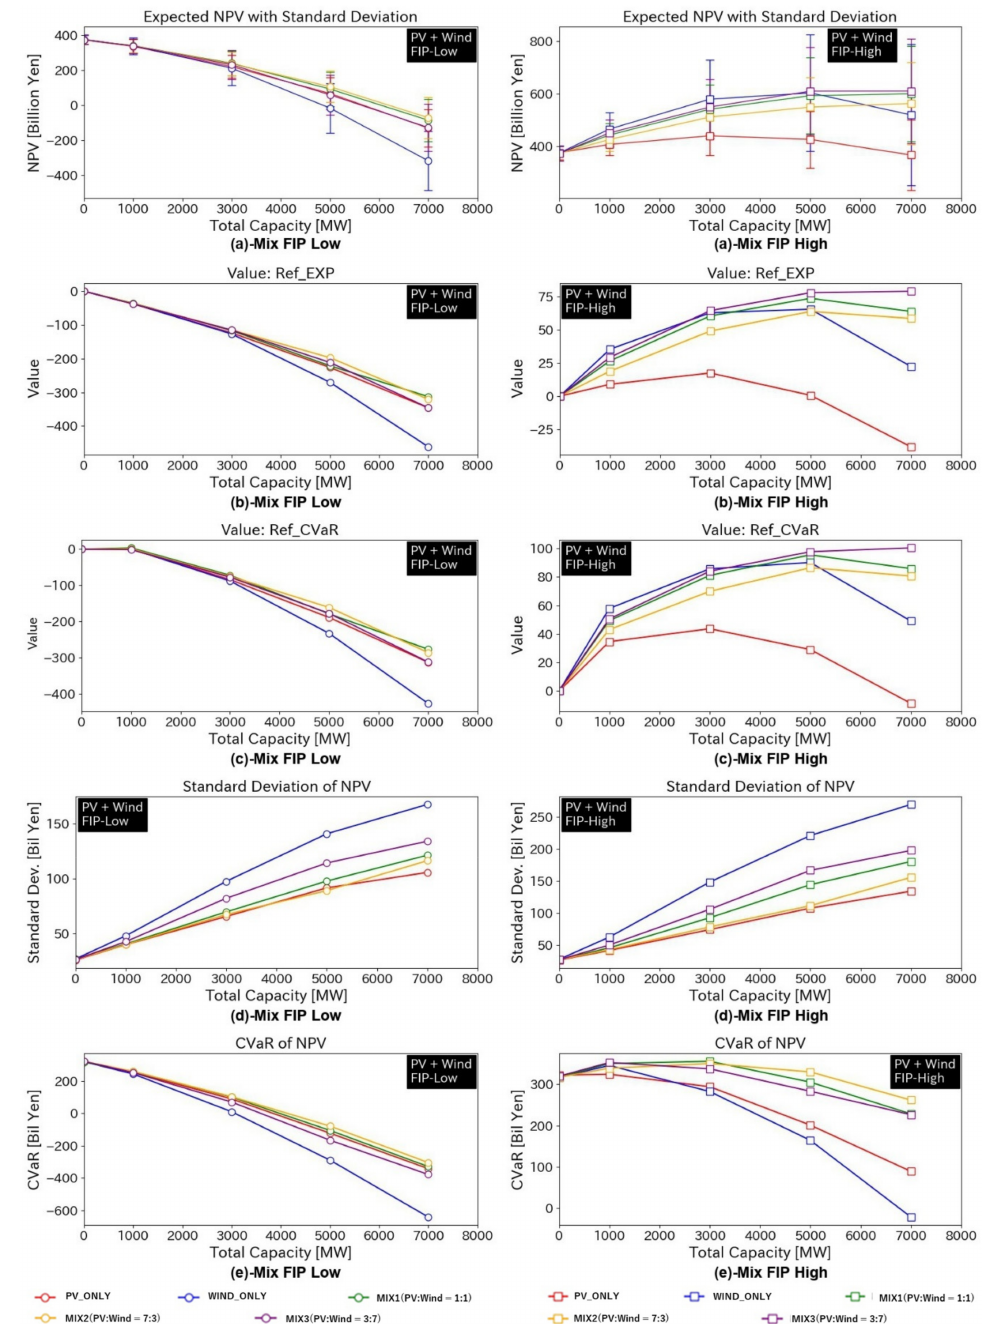
Figure 10. Results of the mixture of VRE: ( a ) Expected NPV with standard deviation, ( b ) Value in case of high RFP, ( c ) Value in case of low RFP, ( d ) Standard deviation of NPV, and ( e ) CVaR of NPV. By comparison, in the case of high FIP, when Company 2 adopted strategies to make a balanced investment in PV and wind, investment in VRE could be expedited compared to the strategies of PV or wind only (Figure 10a (a)-Mix FIP High, Figure 10b (b)-Mix FIP High, Figure 10c (c)-Mix FIP High). The expected NPV and Value of MIX1 (PV:Wind = 1:1), MIX2 (PV:Wind = 7:3), and MIX3 (PV:Wind = 3:7) were higher than those of PV_ONLY and WIND_ONLY; MIX3 (PV:Wind = 3:7) was optimal. Comparison of MIX3 (PV:Wind = 3:7) and WIND_ONLY showed that expected NPV and Value of the 7000 MW investment were the highest for MIX3 (PV:Wind = 3:7) and those of 5000 MW for WIND_ONLY. We found the standard deviation of MIX3 (PV:Wind = 3:7) was lower, and that of CVaR